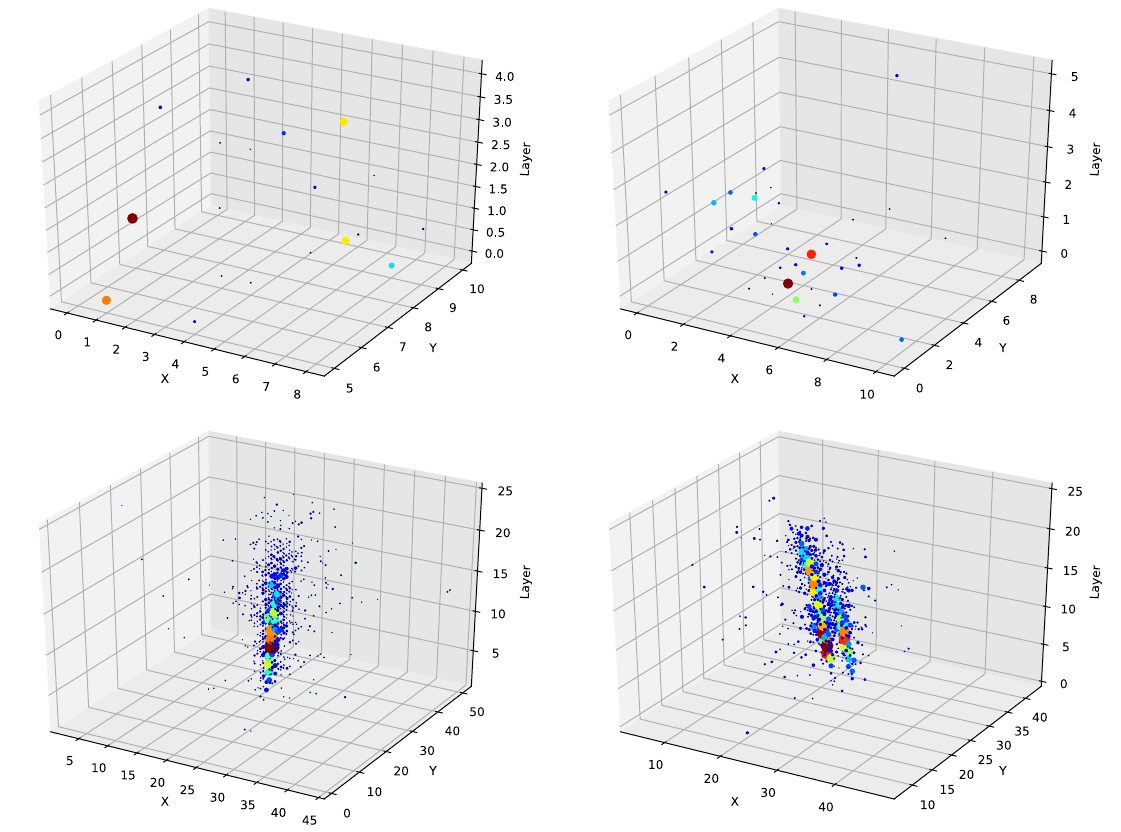
Fig. 1 3D image of a photon (left) and neutral pion (right) shower in ECAL (bottom) and HCAL (top)